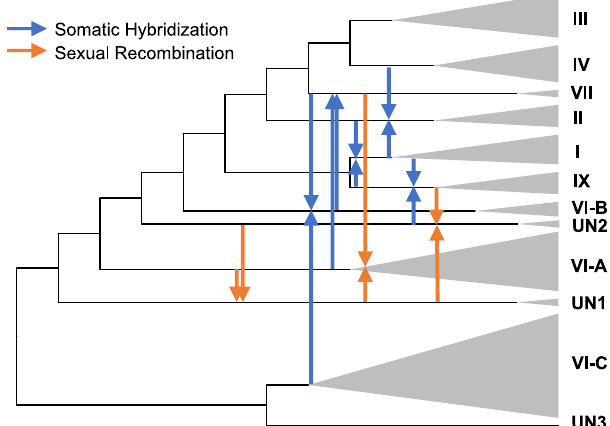
Fig. 7 | Admixture events between clades in the Pgt panel. For each of the eight admixed clades identi fi ed by MOSAIC, its two distinct donor sources are shown witharrows.Theadmixtureeventsaccompaniedbysomatichybridizationorsexual recombination between donor populations are shown with different colors. The reciprocal admixture between the pairs of clades suggests that they share a hap- lotype with similar ancestry.